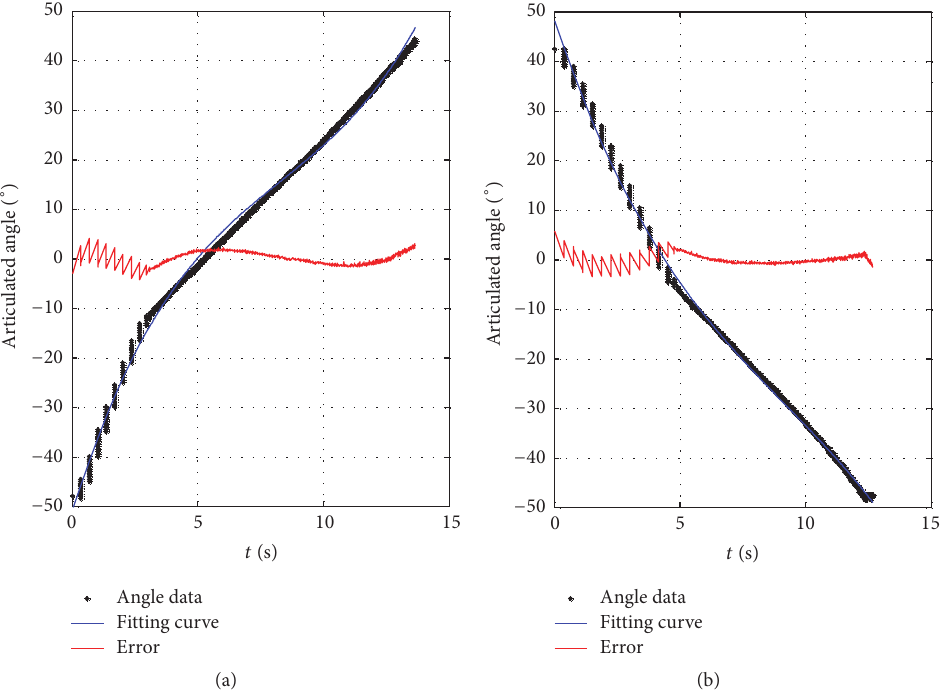
Figure 6: Fitting curves for the vehicle steering from (a) left to right and from (b) right to left.